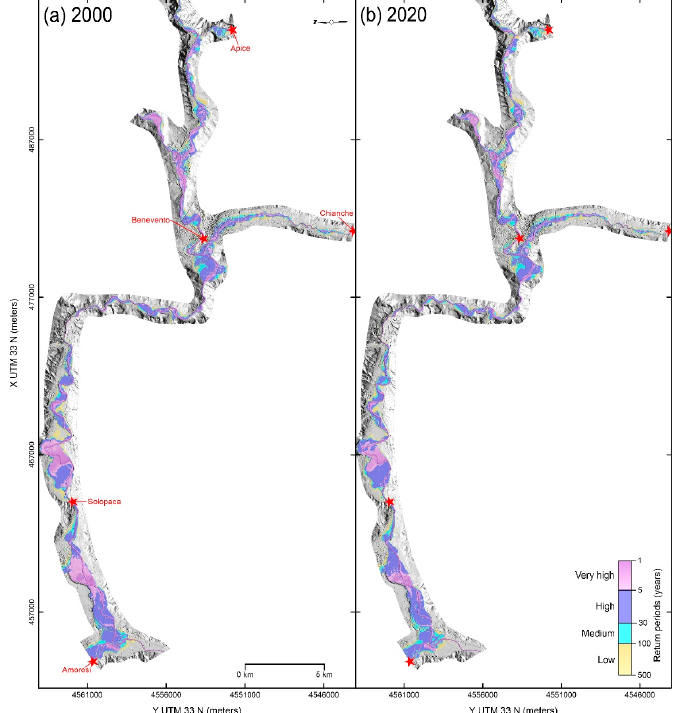
Figure 3. Flood hazard zonation for the ( a ) past (AD 2000) and ( b ) present (AD 2020) flood scenarios. Red symbols indicate hydrometric stations considered in the analysis. UTM 33 N coordinates are shown at the bottom and left sides of the map. Water 2020 , 12 , x FOR PEER REVIEW